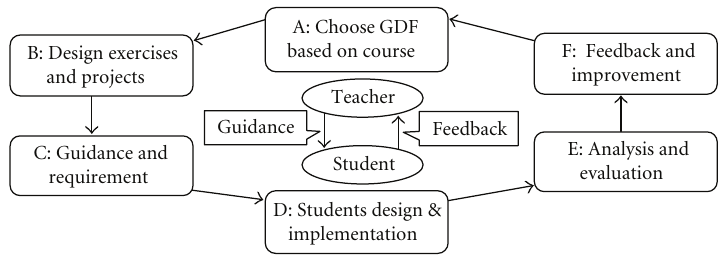
Figure 1: Circulatory model of GDF’s application in